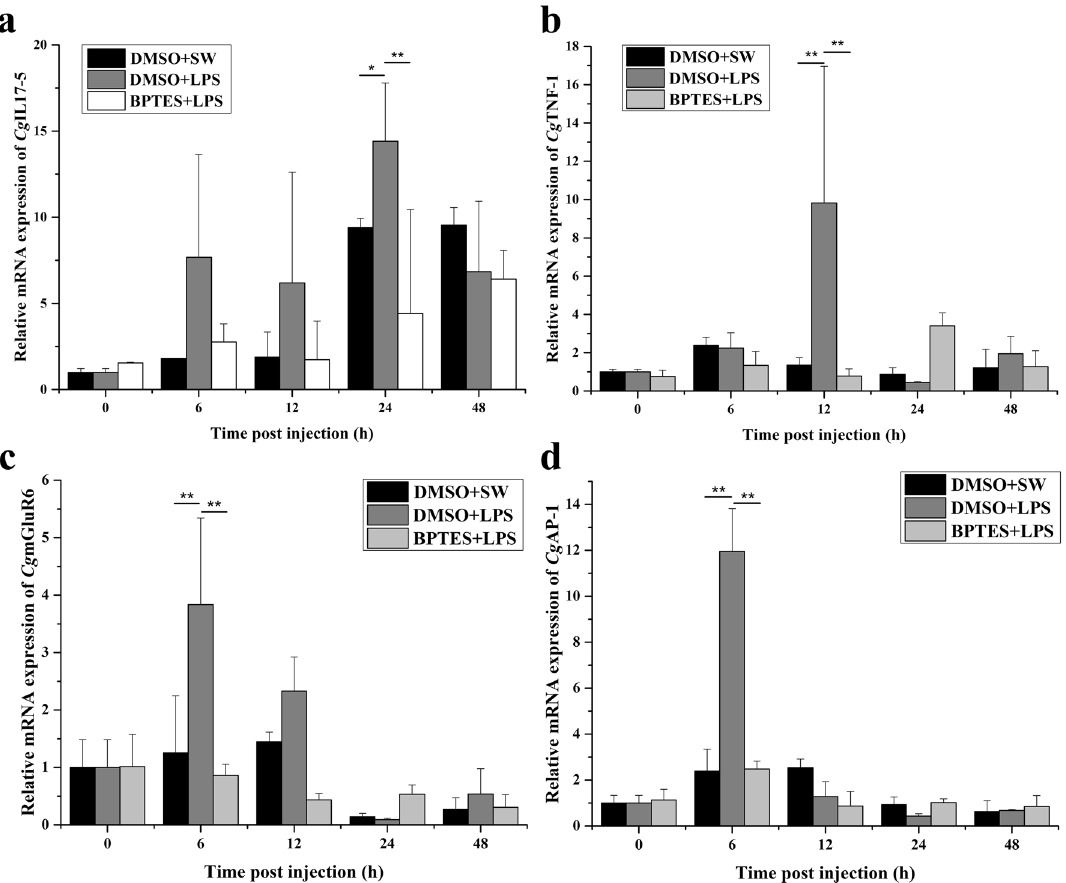
Figure 5. The temporal expression of Cg IL17-5 ( a ), Cg TNF-1 ( b ), Cg mGluR6 ( c ) and Cg AP-1 ( d ) after BPTES and LPS treatments. Each group value is shown as mean ± S.D. (N = 3). Asterisks indicate significant differences. (* p < 0.05; ** p <